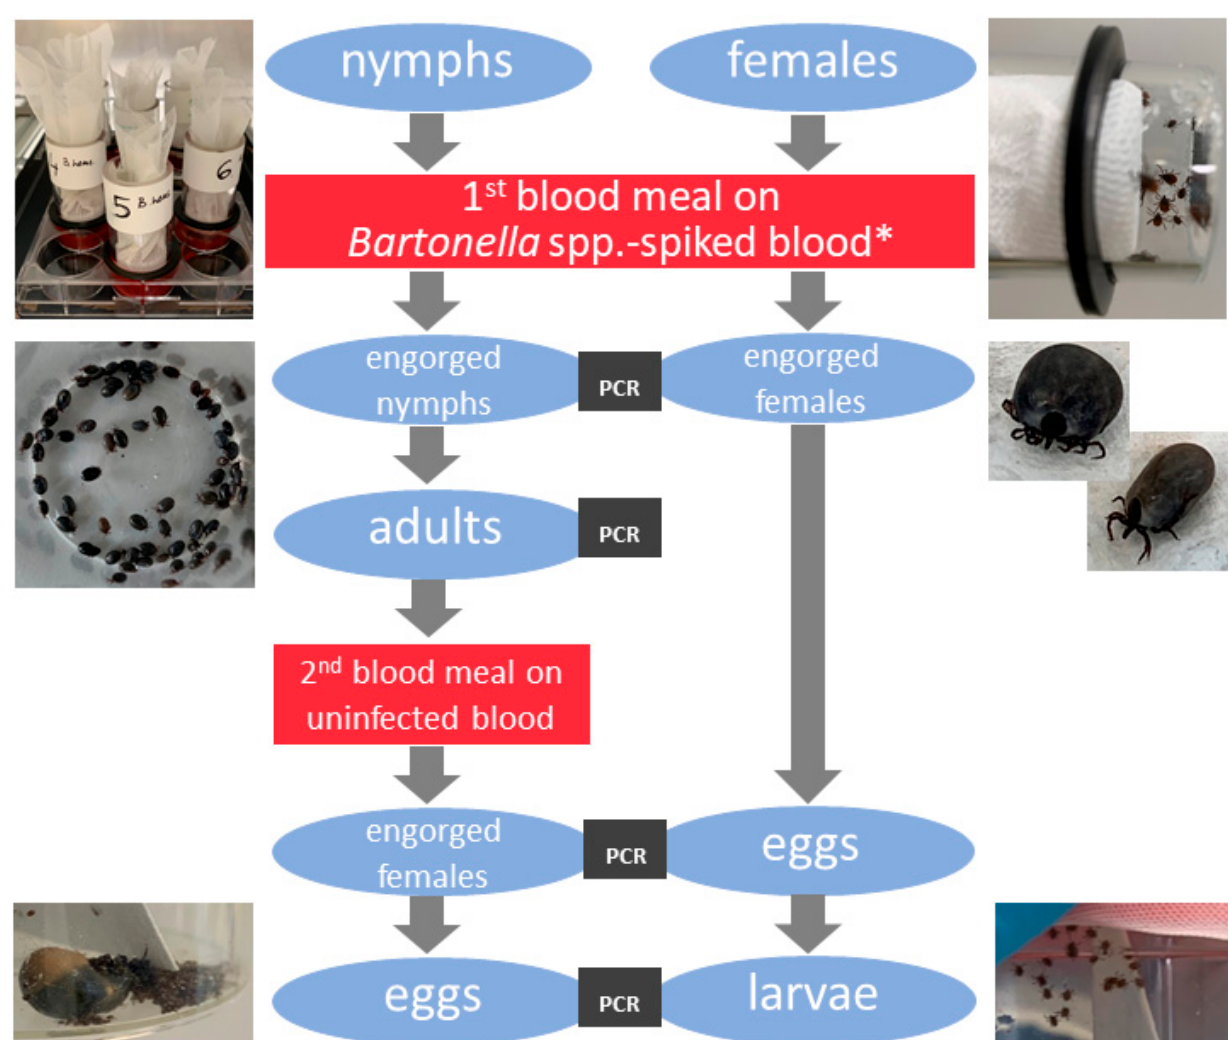
Figure 1. Study design of infecting Ixodes ricinus ticks with Bartonella spp. using the artificial feeding (* blood for negative control groups was spiked with PBS).